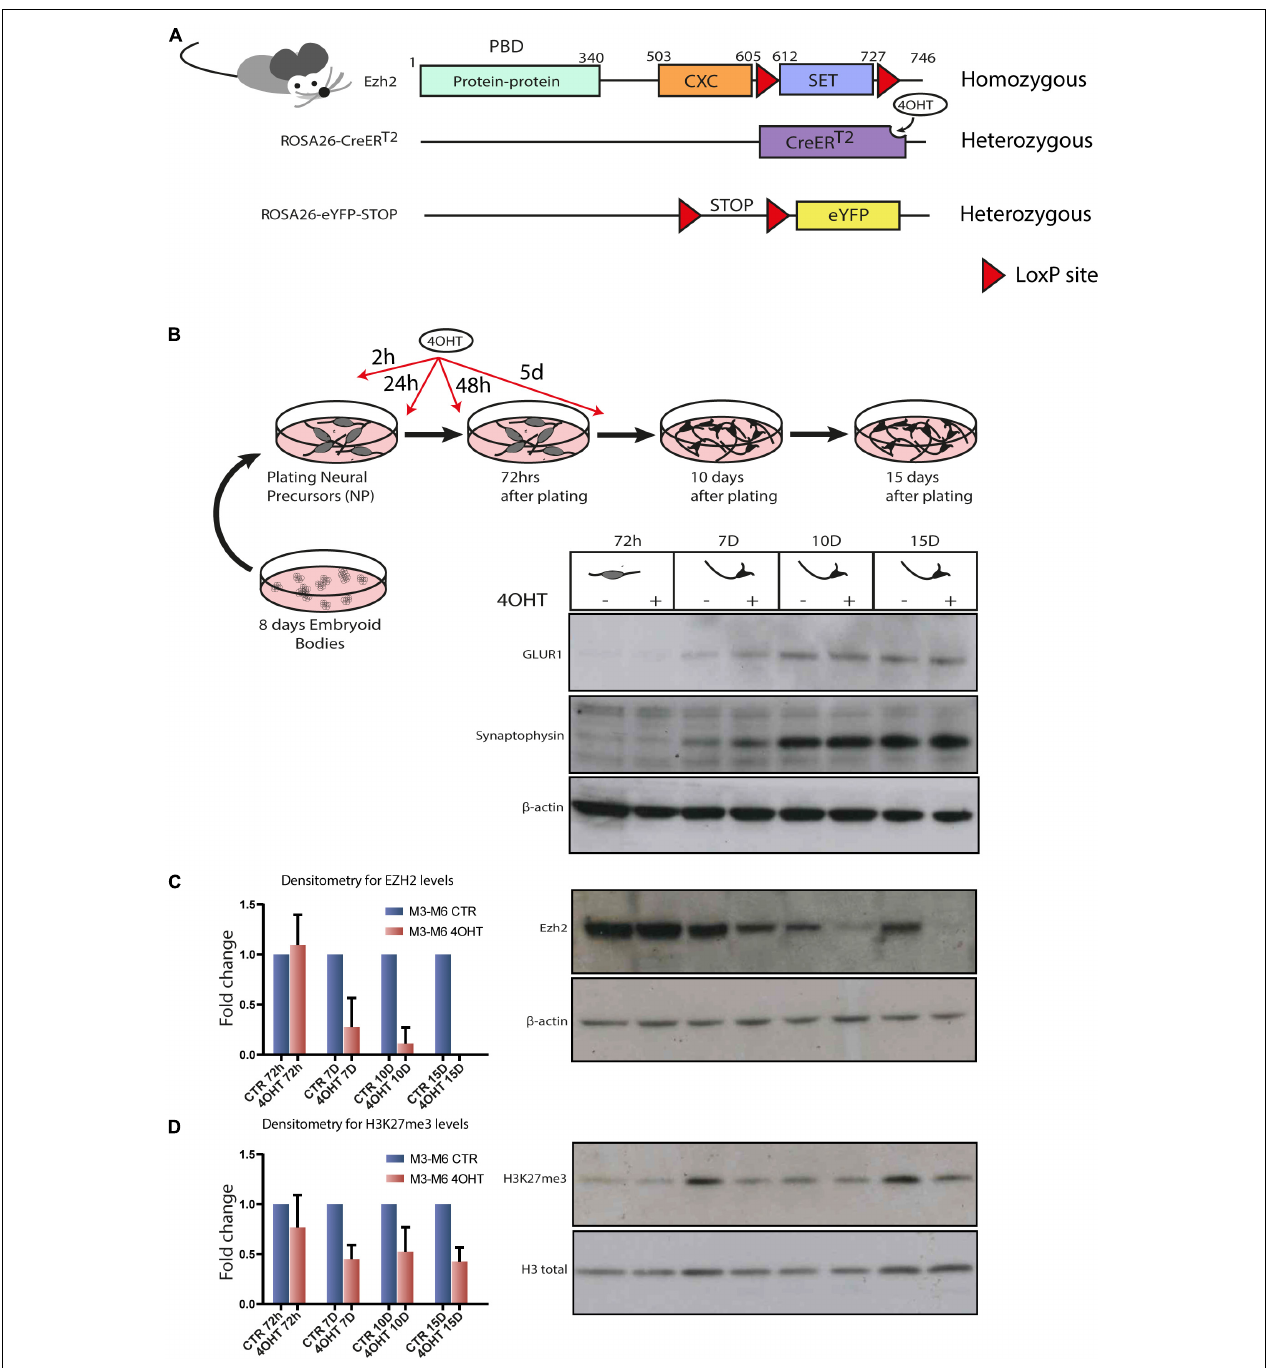
FIGURE 1 | Establishment of an Ezh2 conditional deletion model to study its role during terminal neuronal differentiation. (A) Schematic of transgenic mouse strain Ezh2 flox / flox rosa26 (CreERT2)/rosa26-eYFP used for the conditional deletion of Ezh2. (B) Graphical representation of the neuronal differentiation protocol used to derive mature post-mitotic glutamatergic neurons. Western blots for neuronal markers GLUR1 and Synaptophysin at 72h, 7D, 10D and 15D after neuronal progenitors plating using β -actin as loading control. (C) Representative western blot for EZH2 and densitometric analysis expressed as fold change of 4OHT samples compared to controls for every time point. The analysis was performed on 2 independent biological replicates from independent cell lines carrying the Ezh2 flox / flox allele (M3 and M6) (mean ± SD, one sample t -test). (D) Representative western blot for H3K27me3 and densitometric analysis relative to histone H3 total signal. The analysis was performed on 2 independent biological replicates from independent ESC lines carrying the Ezh2 flox / flox allele (M3 and M6) (mean ± SD, one sample t -test).